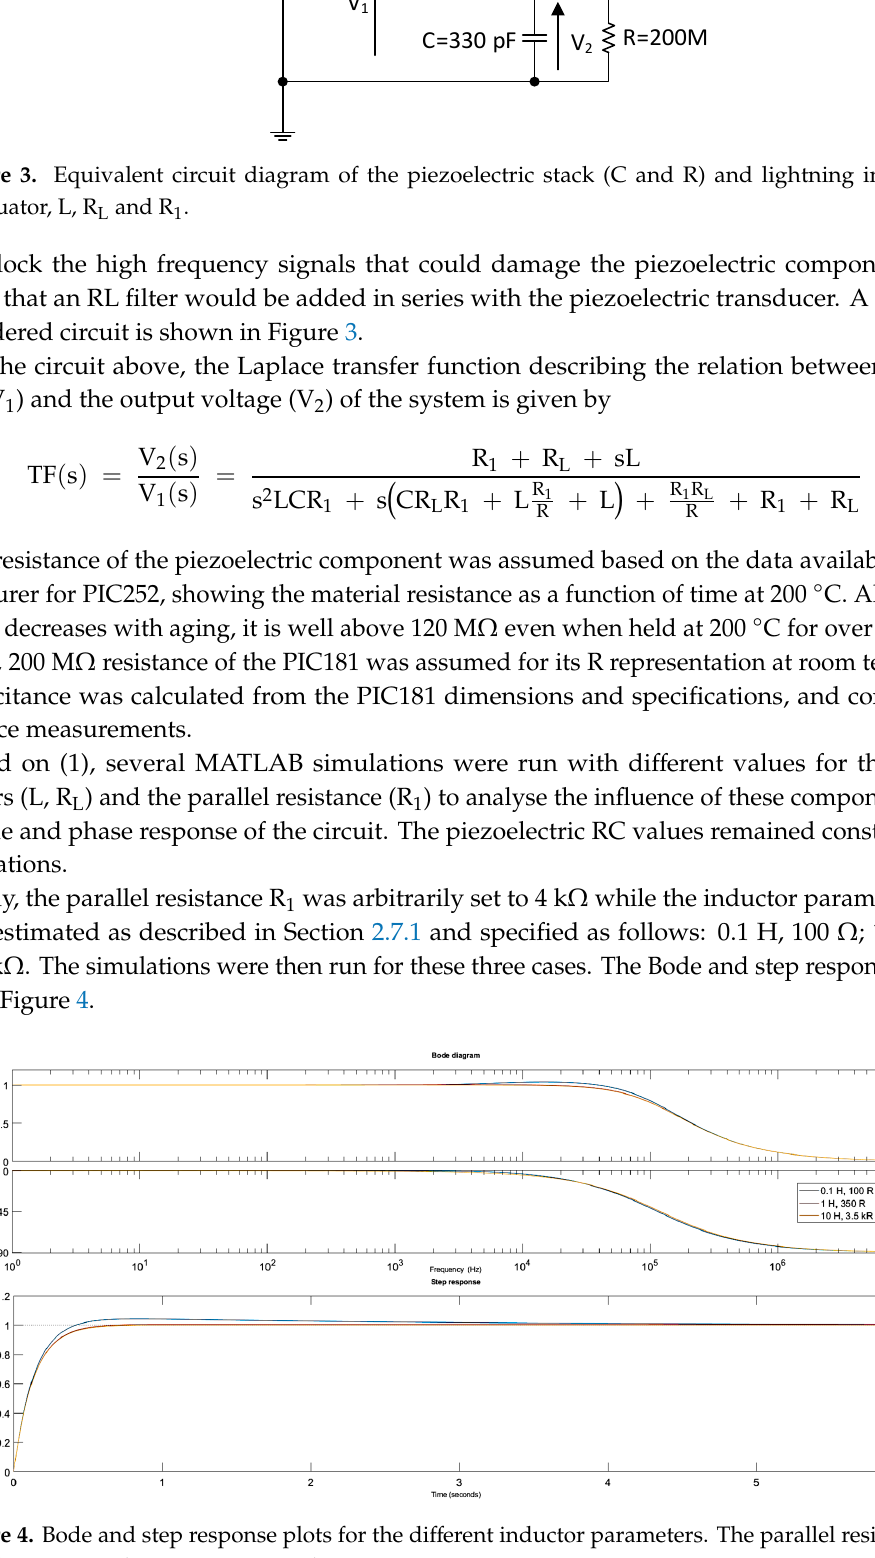
Figure 4. Bode and step response plots for the different inductor parameters. The parallel resistor R 1 and the piezo stack settings remained constant.